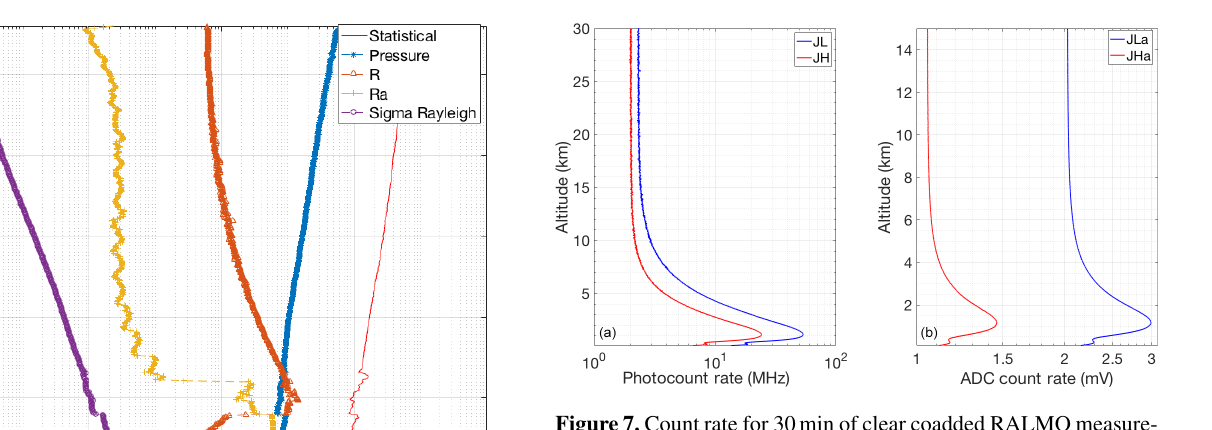
Figure 7. Count rate for 30min of clear coadded RALMO measure- ments from 11:00UT on 10 September 2011; (a) Photon-counting channels (blue curve, JL; red curve, JH); (b) Analog